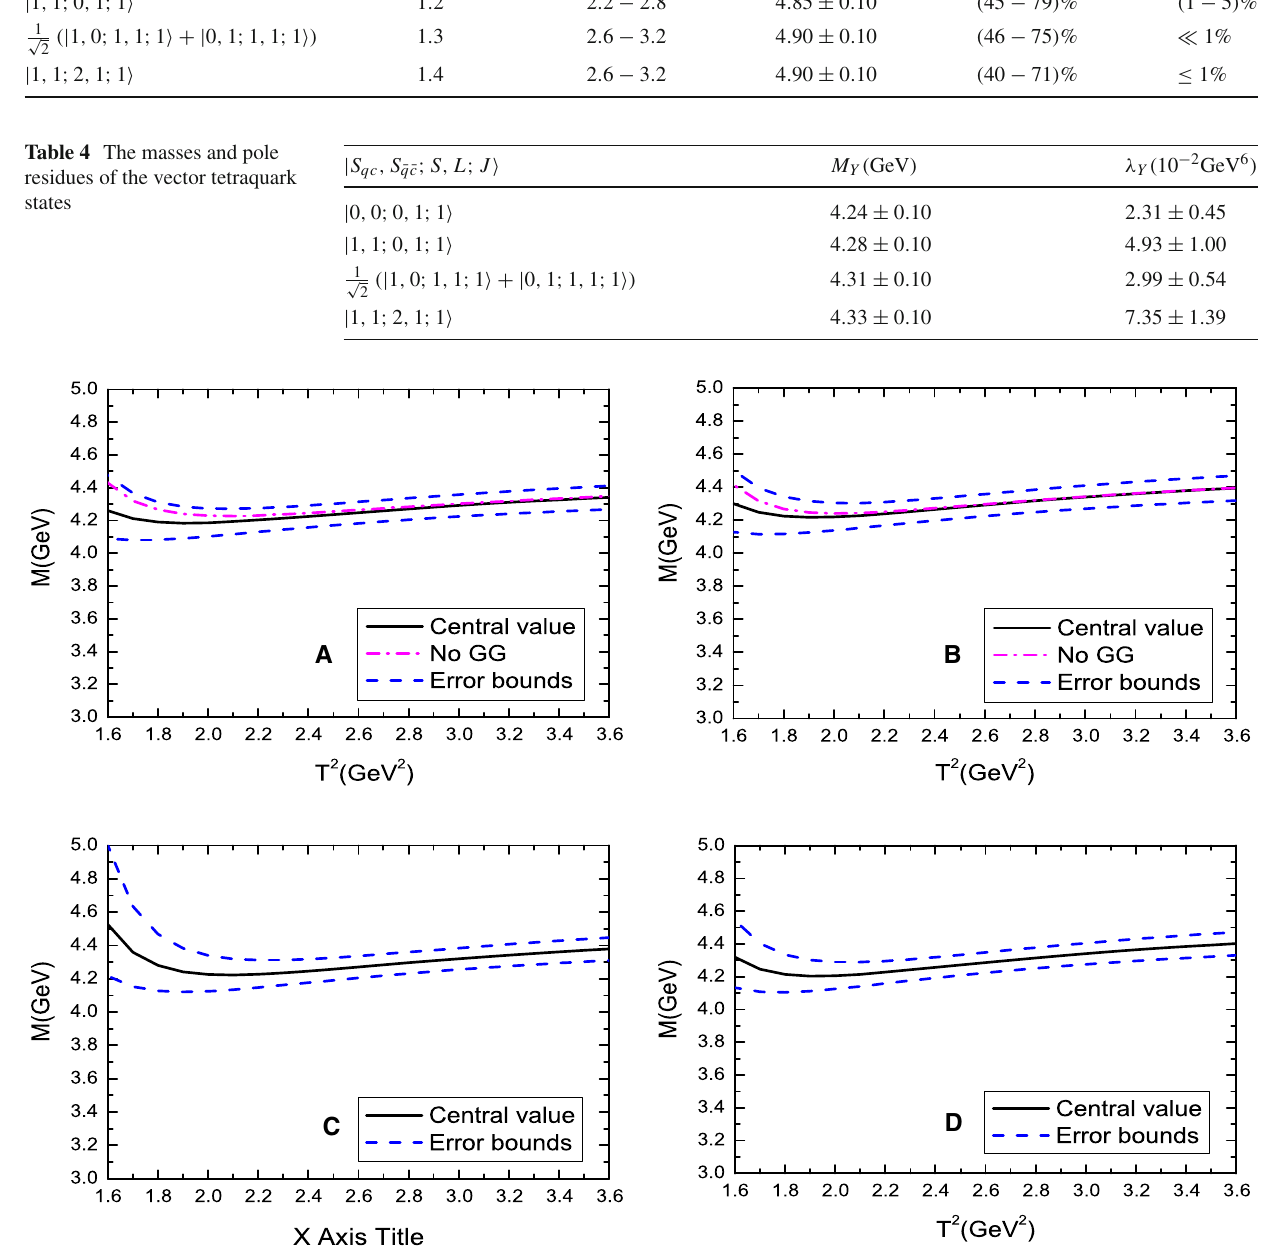
Fig. 1 The masses of the vector tetraquark states with variations of the Borelparameters T 2 ,wherethe A , B , C and D denotethe | 0 , 0 ; 0 , 1 ; 1 (cid:8) , | 1 , 1 ; 0 , 1 ; 1 (cid:8) , 1 √ ( | 1 , 0 ; 1 , 1 ; 1 (cid:8) + | 0 , 1 ; 1 , 1 ; 1 (cid:8) ) and | 1 , 1 ; 2 , 1 ; 1 (cid:8) 2